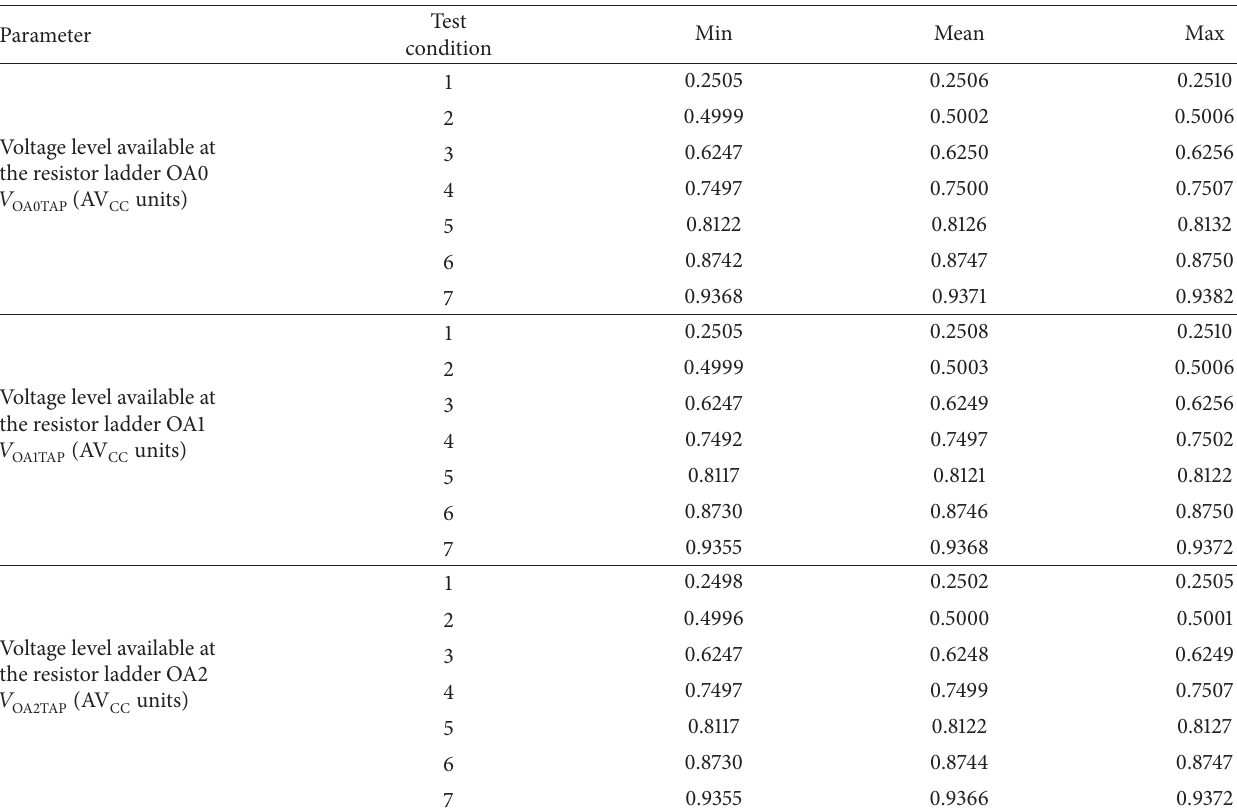
Table 4: Resistor ladder test experimental